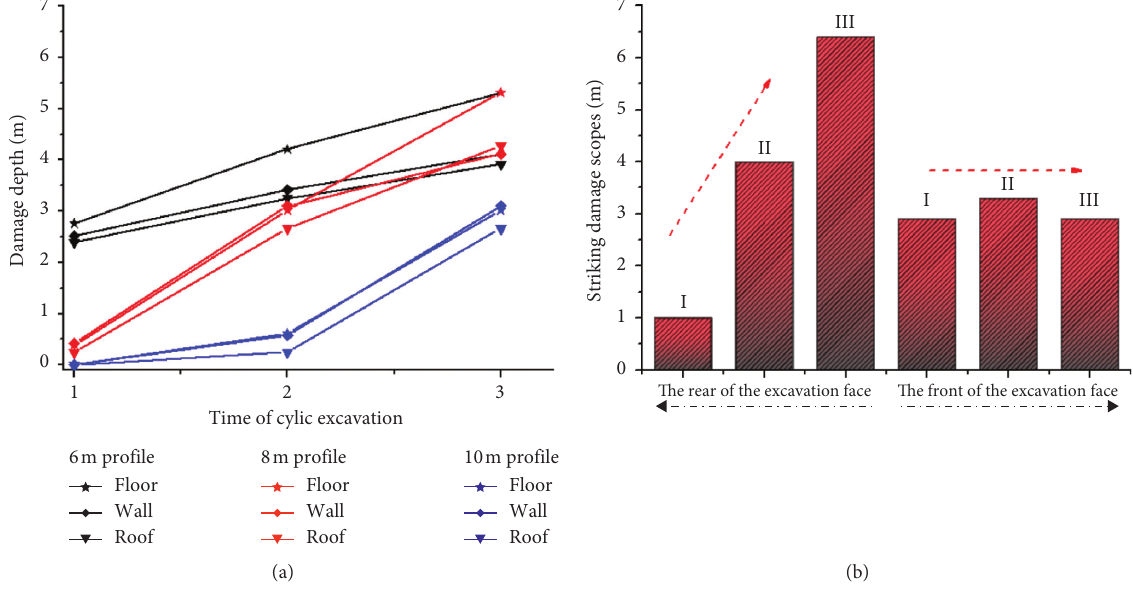
Figure 12: Damage scope of the surrounding rocks. (a) Circumferential damage. (b) Striking damage.